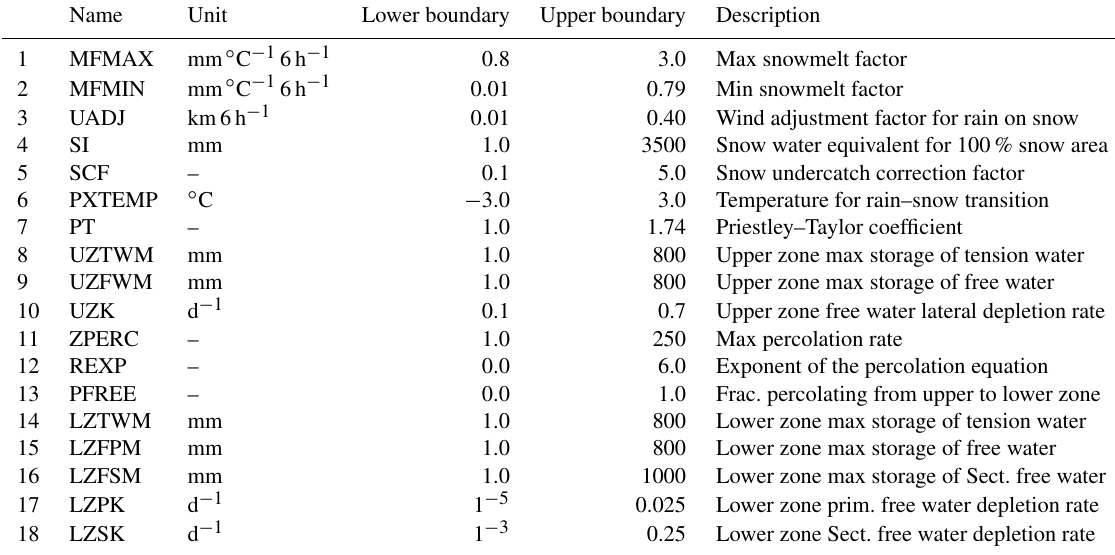
Table A2. Selected parameters and their boundaries for the SAC model. The parameter boundaries are based on Newman et al. (2015), and the Priestley–Taylor parameter has been adapted based on Lhomme